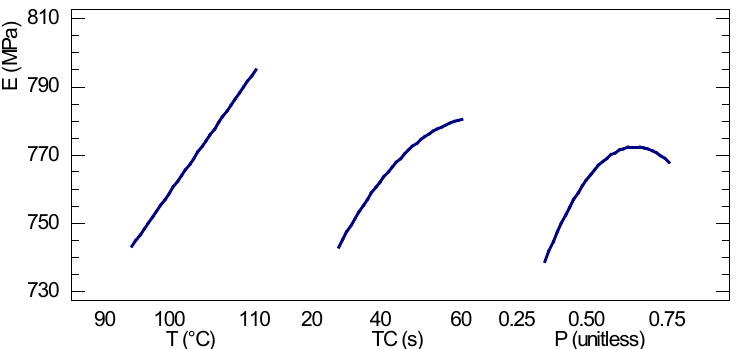
Figure 8. Main e ff ects for the elastic modulus considering the experimental factors of process Figure 8. Main effects for the elastic modulus considering the experimental factors of process temperature, compaction time and proportion of rice husk in the mixture. temperature, compaction time and proportion of rice husk in the mixture.